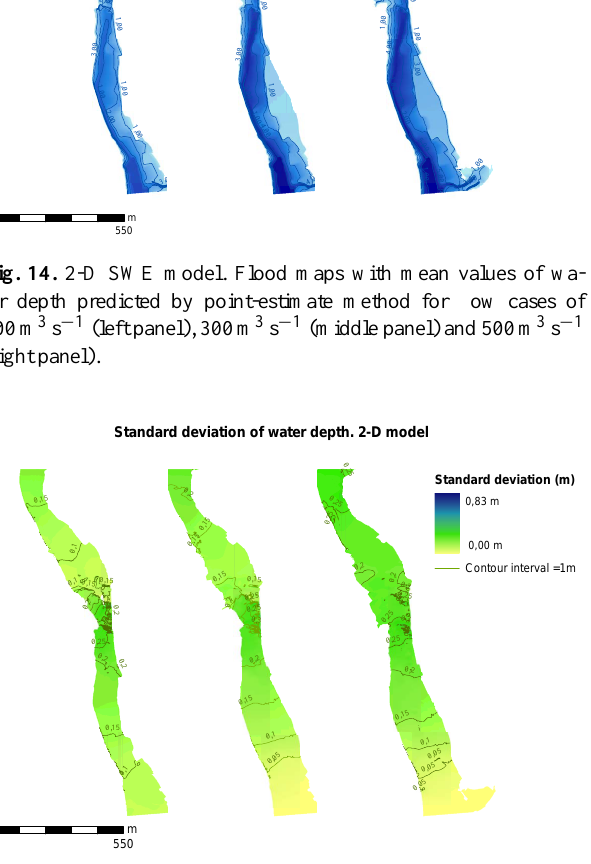
Fig. 15. 2-D SWE model. Flood maps with standard deviation val- ues of water depth predicted by point-estimate method for flow cases of 200m 3 s − 1 (left panel), 300m 3 s − 1 (middle panel) and 500m 3 s − 1 (right panel).